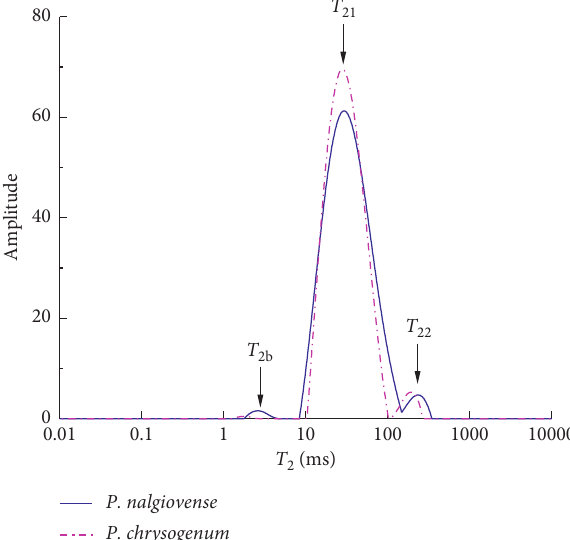
Figure 6: Distribution of T2 in chicken meat fermented with P. nalgiovense and P. chrysogenum .